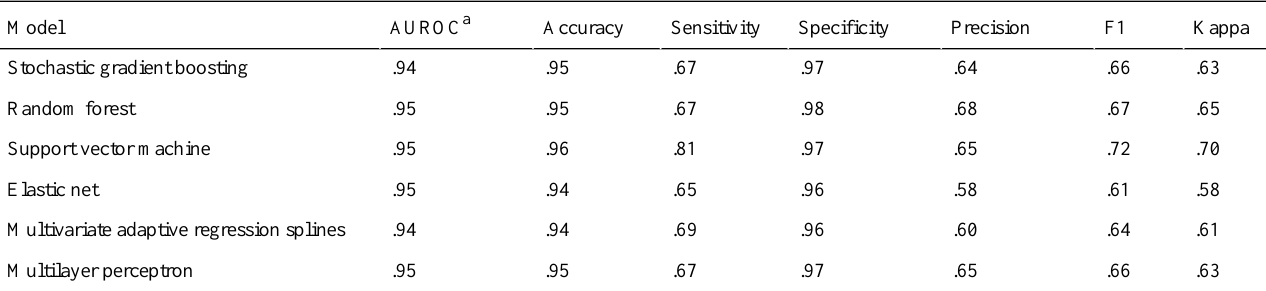
Table 2. Predictive performance of candidate machine learning models based on evaluation on the test